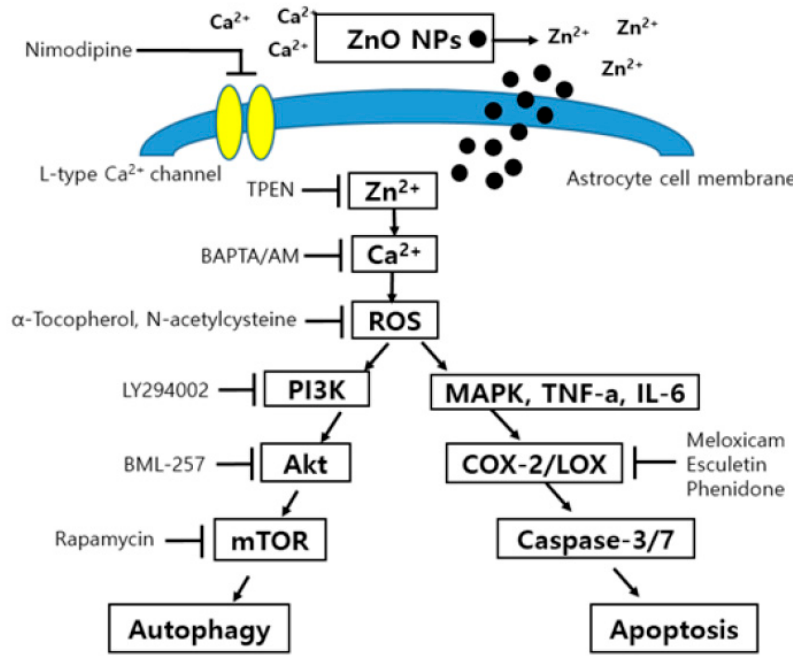
Figure 11. Possible mechanism of ZnO NP-induced toxicity in primary cultured astrocyte cells.